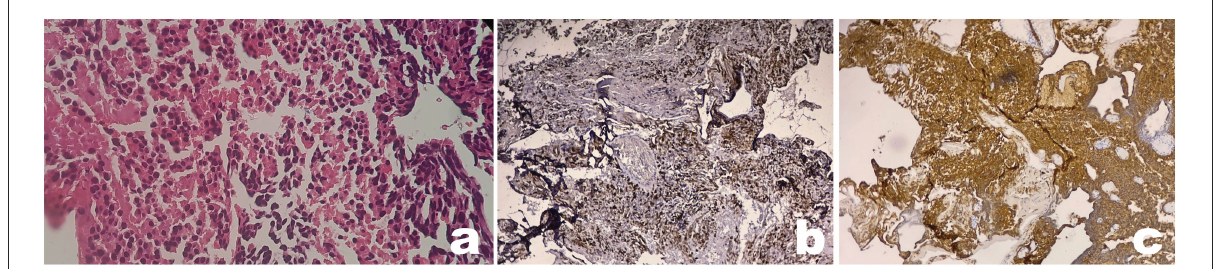
FIGURE3 Pathology from implantation metastasis shows a typical pineal parenchymal tumor of intermediate differentiation (PPTID). Microscopy examination of tumor showed round-shaped cells with vesicular hyperchromatin, scanty eosinophilic cytoplasm, and nuclear atypia (a) . Immunohistochemical analyses show positive expression of synaptophysin (b) and chromogranin (c) (x100 magnification).